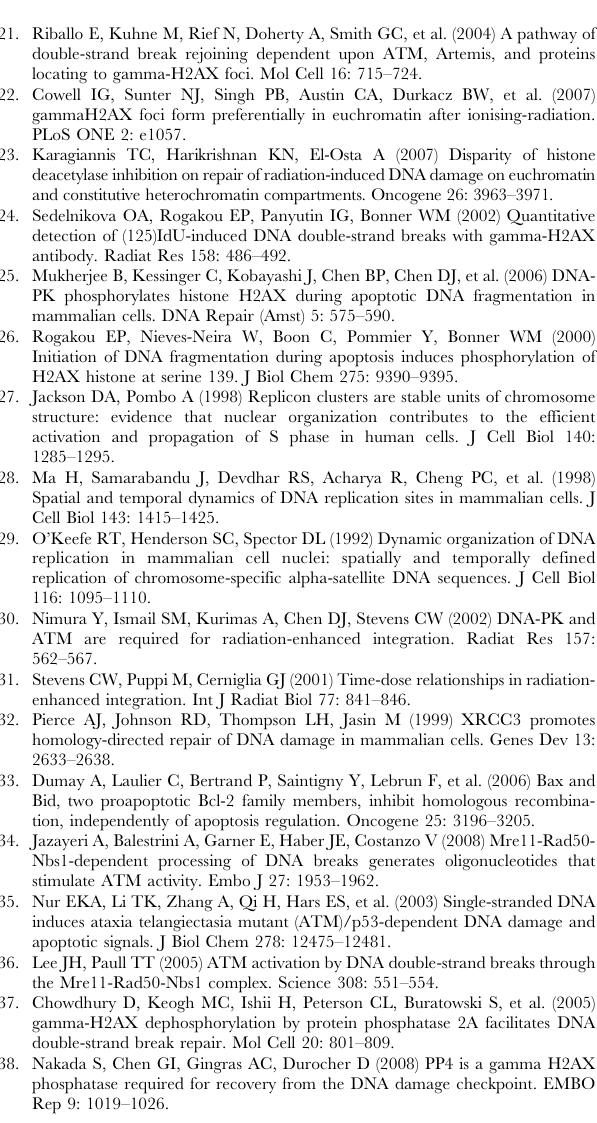
Figure S1 List of Dbait molecules. Found at: doi:10.1371/journal.pone.0006298.s001 (0.69 MB TIF) Figure S2 Effect of inhibitors on 32Hc treatment and necessity of DNA-PK for cell sensitization to irradiation. Found at: doi:10.1371/journal.pone.0006298.s002 (0.76 MB TIF)